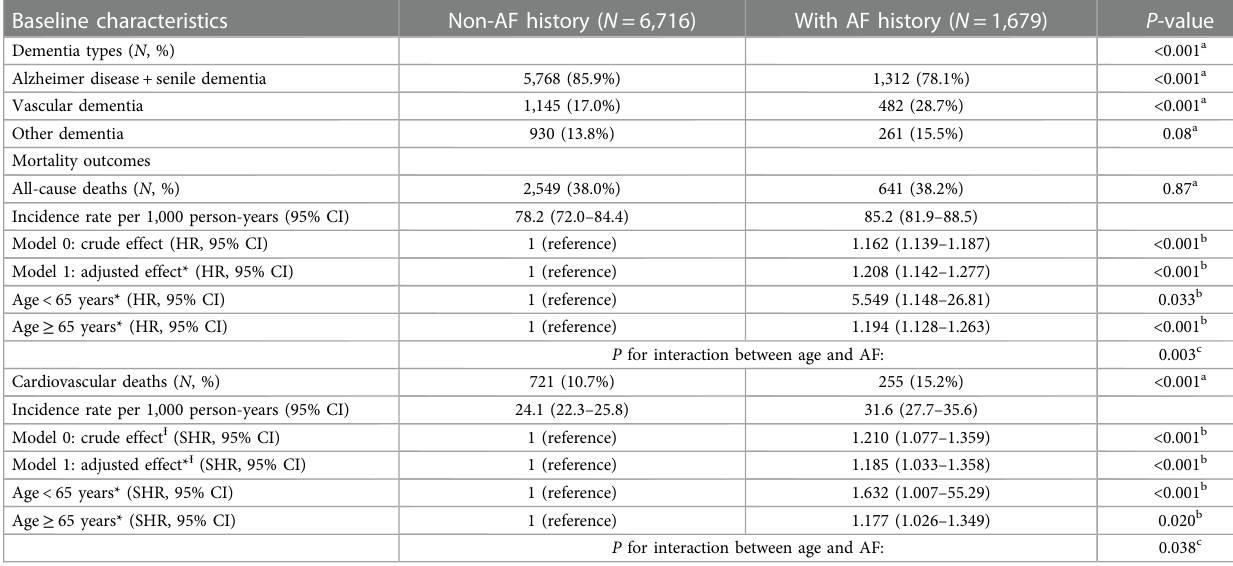
TABLE 2 Dementia types and mortality outcomes in the dementia cohort dividing by a history of atrial fi brillation or not. Baseline